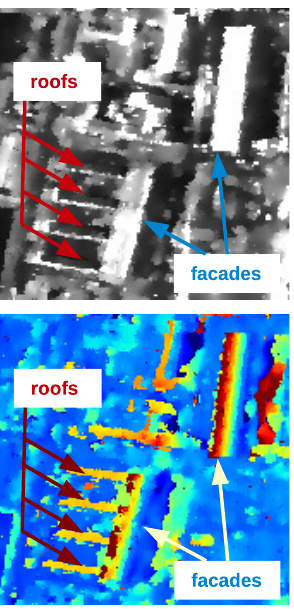
Figure 8: Comparison of roof and facades as they appear in (a) the intensity image and (b) the height maps obtained with tomogra- phy. Facade appear as bright structures in the radiometric image and heights ramps in the point cloud. Roofs have low amplitude in the image but are well visible in the height map.